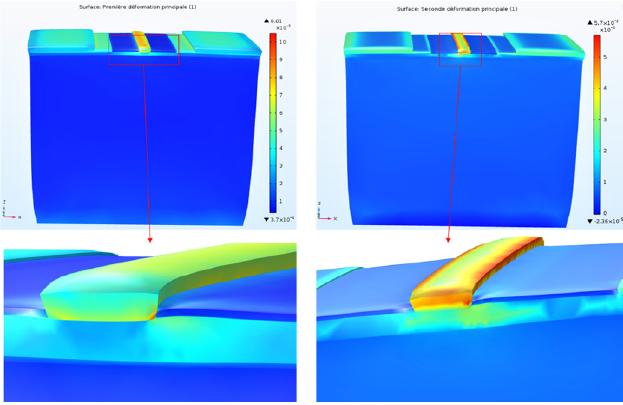
Fig. 7. Distribution of principal strains in the HEMT structure.